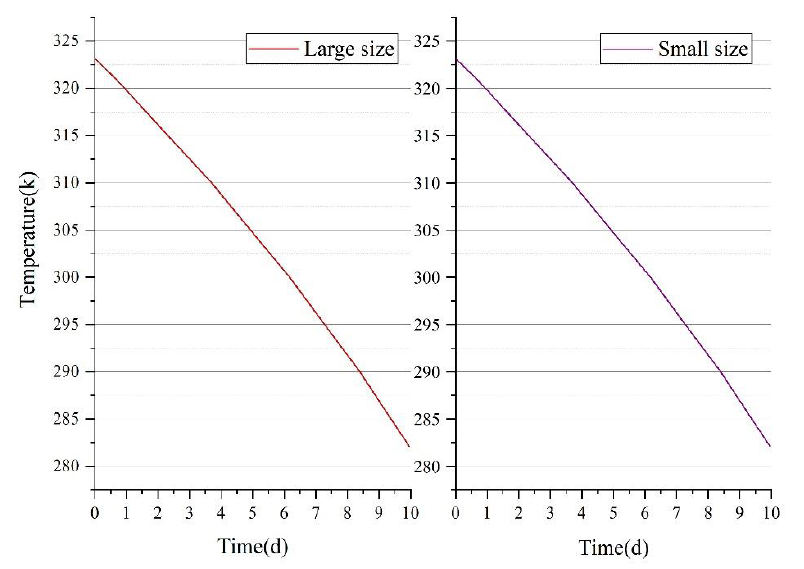
Figure 12. Diagram of temperature over time.